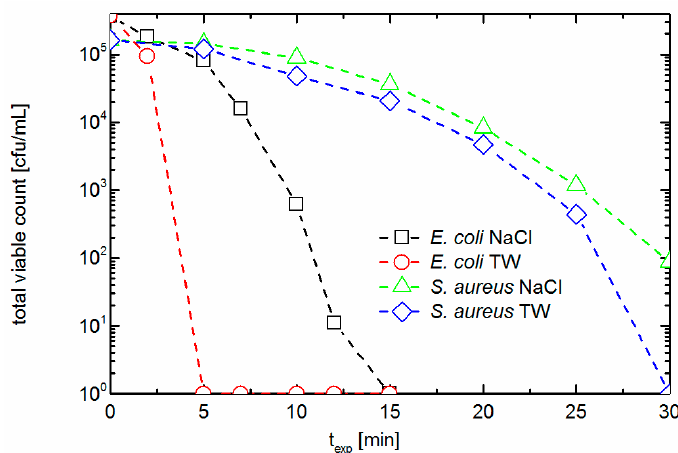
Figure 9. Antimicrobial effect of plasma-treated saline solution (NaCl) on E. coli (boxes) and S. aureus (triangles) as well as plasma-treated tap water (TW) on E. coli (circles) and S. aureus (rhombi), t treat = 30 min.